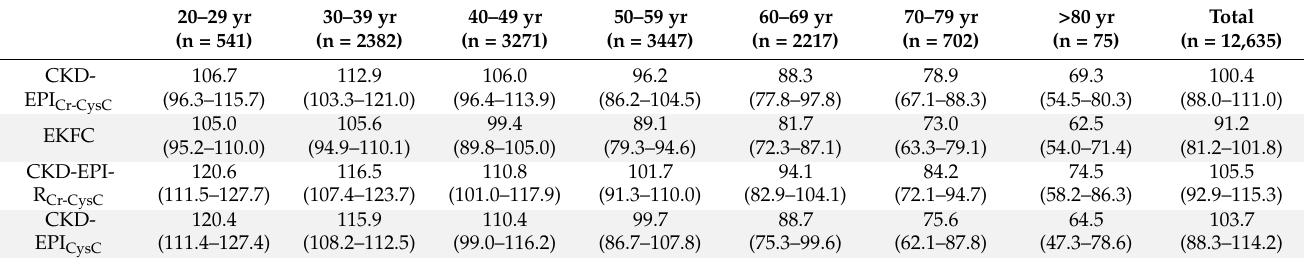
Figure 3. Bland–Altman plots to compare CKD-EPI, EKFC, and CKD-EPI-R equations. ( A – C ) Dif- ferences of eGFR among serum creatinine-based CKD-EPI, EKFC, and CKD-EPI-R equations (n = 106,021). ( D – F ) Differences of eGFR among cystatin C-based CKD-EPI, EKFC, and CKD-EPI-R equa- tions (n = 12,635). Solid lines indicate mean difference, and dashed lines indicate ±1.96 standard deviations. Abbreviations: see Table 3. Table 3. Distribution of eGFR using serum creatinine- and cystatin C-based CKD-EPI, EKFC, and CKD-EPI-R equations stratified by age group.